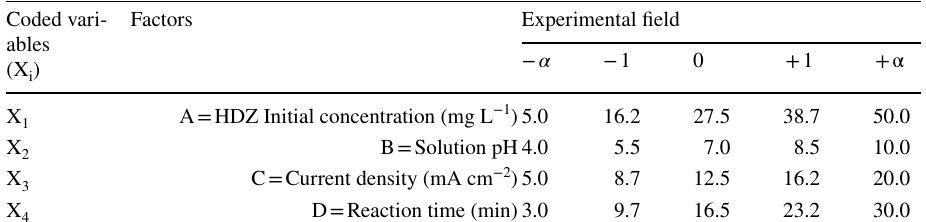
Factors Experimental Coded vari- ables (X i )